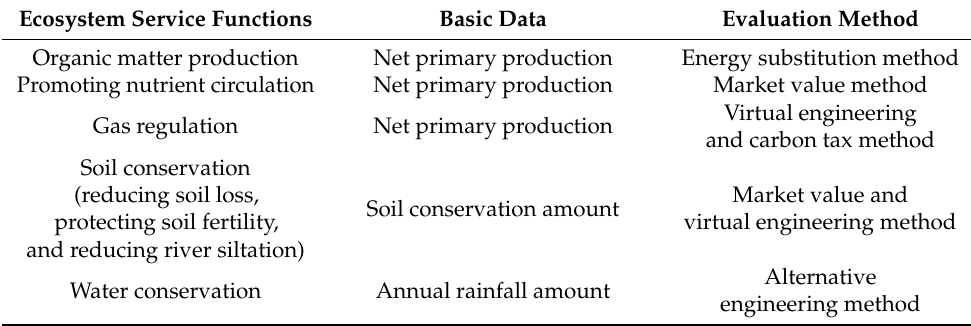
Table 2. Ecosystem service value assessment system of grassland in this